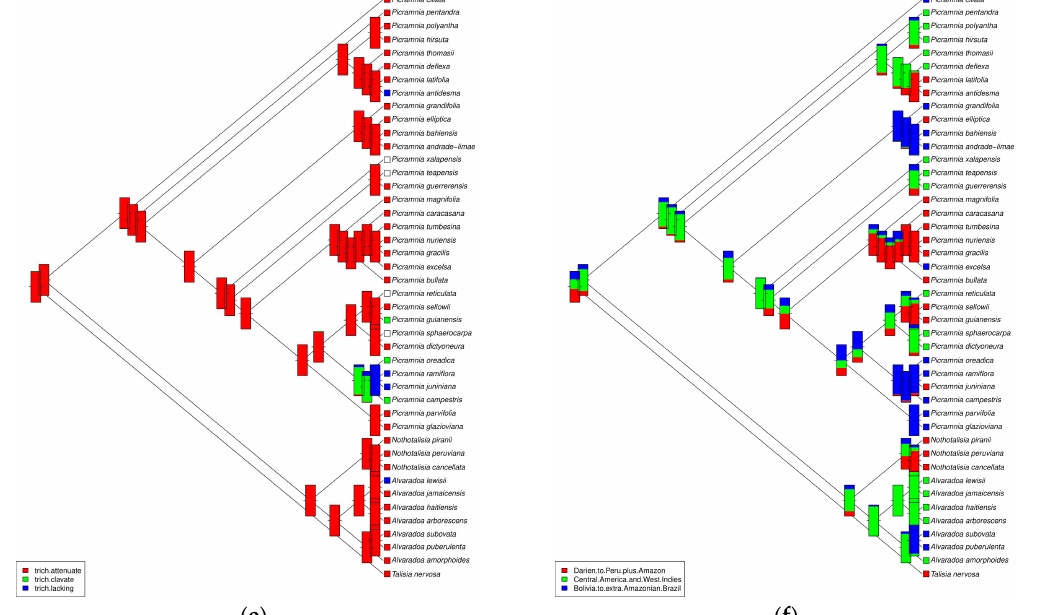
Figure 5. Ancestral character estimation on six different types of characters: ( a ) number of carpels, ( b ) position of the inflorescence, ( c ) type of the inflorescence, ( d ) merosity of flower, ( e ) type of trichomes, ( f ) geography on the regional level.